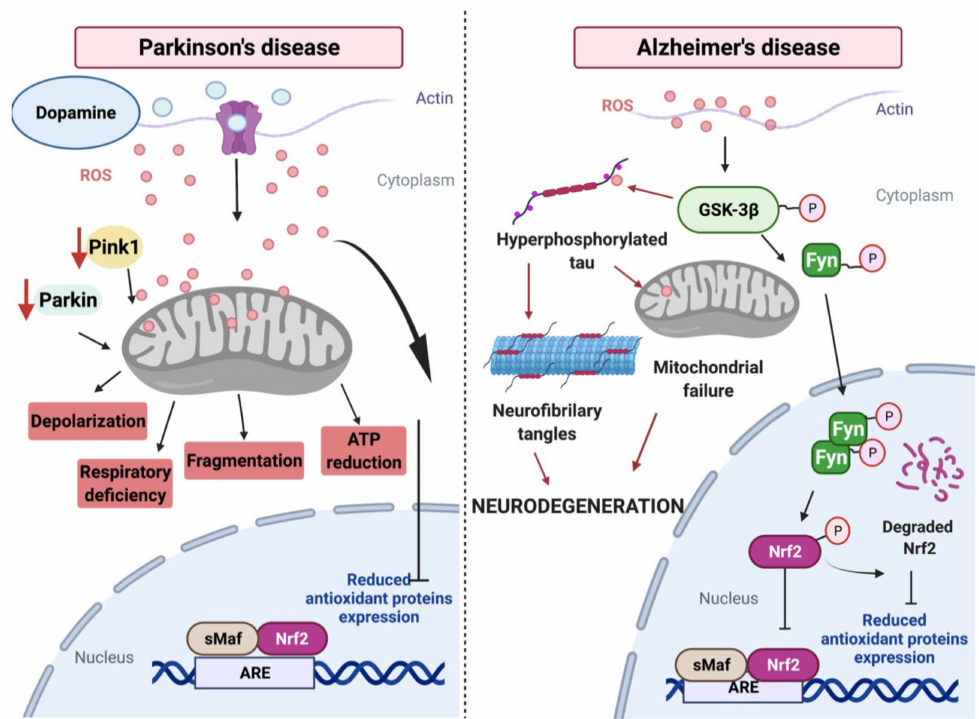
Figure 2. Contribution of the Nrf2 pathway to the pathogenesis of Parkinson’s disease and Alzheimer’s Disease. In PD, an increase in the dopamine release could affect mitochondrial function, producing an increase in ROS levels affecting Nrf2 activity and the response against the oxidative damage. Additionally, the decrease in Parkin and PINK expression levels shown in PD could affect mitochondrial function, inducing depolarization, fragmentation, respiratory deficiency, and ATP re- duction. These changes will affect synaptic function, contributing to neurodegeneration and cognitive impairment present in PD. In AD, the GSK-3 β protein, which is a kinase that promotes the anomalous phosphorylation of tau protein, promotes Nrf2 degradation by proteasome activity through the Fyn’s phosphorylation. Additionally, during AD, activated GSK-3 β induces tau